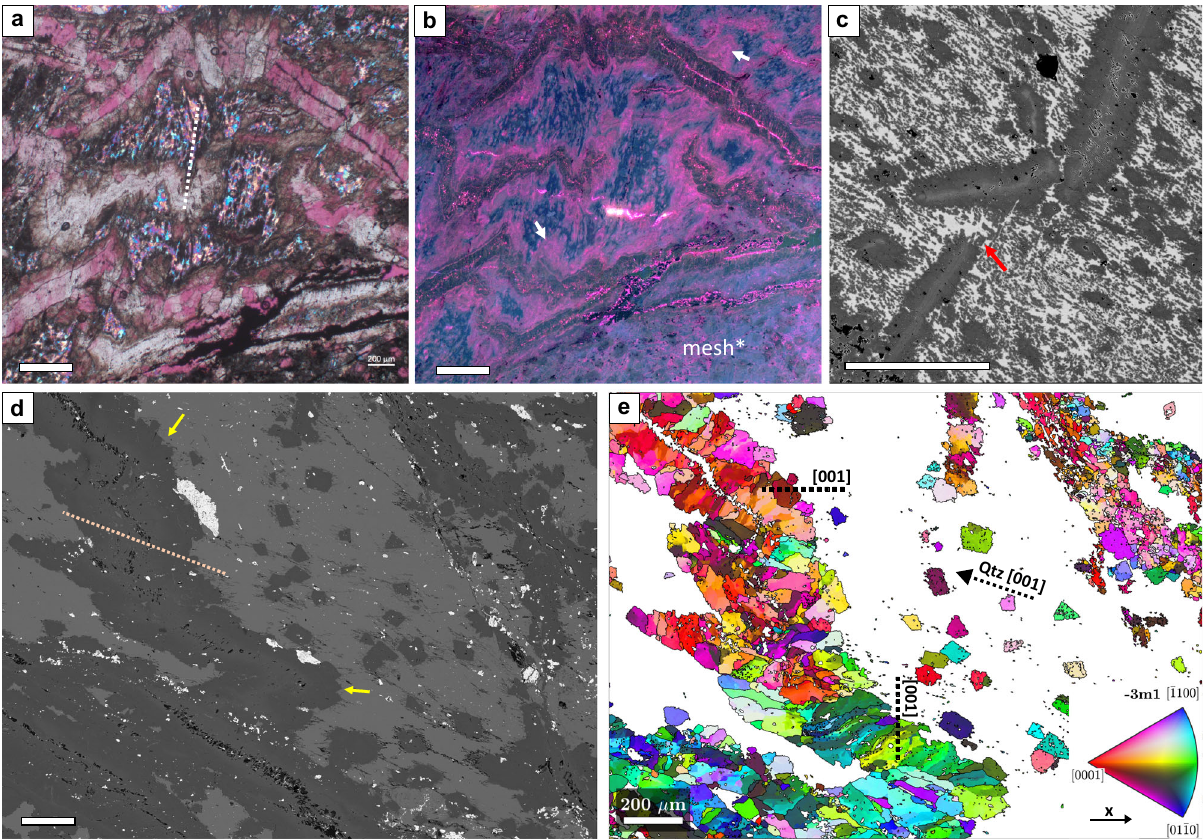
Fig. 5 Ductile transposition and folding of early magnesite veins. a folded magnesite veins, the matrix consists of quartz and aligned magnesite dendrites (crossed polarized light with 1 λ -plate; BT1B_21-3_35-40). b Optical cathodoluminescence image of the same area as in a , showing pink luminescent magnesite overgrowth on folded veins (arrows). In the lower right domain listvenite resembles a mesh texture and veins are not folded. c Back-scattered electron (BSE) image of transposed magnesite vein with magnesite dendrites growing oblique to the foliation in the opening space (red arrow). In this image, the contrast was enhanced and oxides are rendered black (BT1B_20-1_64-68). d BSE image of folded magnesite vein, with euhedral magnesite overgrowths on the vein rims (yellow arrows) (BT1B_16-3_28-31). e Electron backscatter diffraction (EBSD) orientation map of magnesite of the same area as in d (ipf color scale see inset), with average orientation of magnesite [001] in different vein parts and of quartz (Qtz) [001] in the matrix indicated (c.f. Figure 4). In a and d , dotted lines mark the trace of the fold axial surfaces and the parallel shape preferred orientation of dendritic magnesite. Scale bar in a and b is 400 µ m, in c – e 200 µ